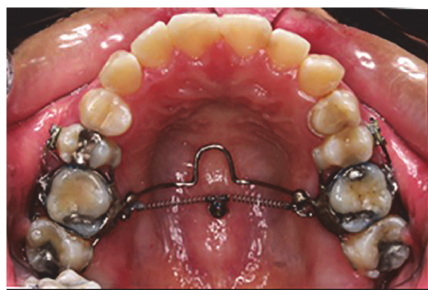
Figure 1: Intraoral photograph showing the segmental posterior tooth intrusion (group-of-six) treatment modality using an intru- sion transpalatal arch with tags and two nickel-titanium closed coil springs (100g of force each). One titanium miniscrew implant (2.0 mm diameter, 6.0mm length) was placed in themidpalatal